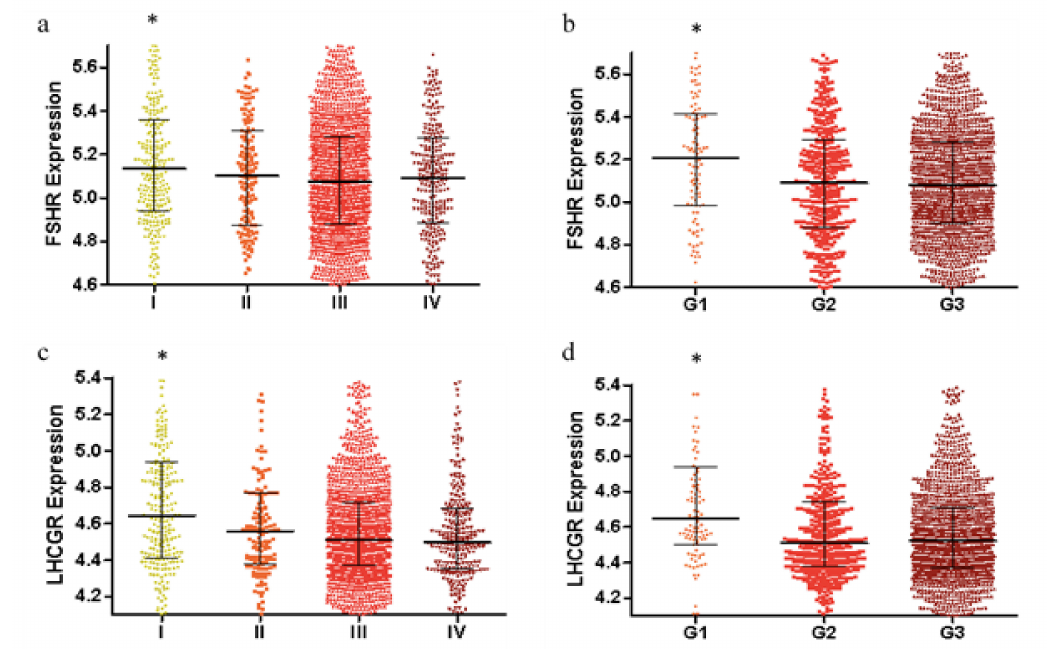
Figure 1. FSHR and LHCGR mRNA expression is increased in early stage and low-grade ovarian cancers: ( a ) FSHR expression in stage I, II, III and IV ovarian cancers; ( b ) FSHR expression in grade I, II and III ovarian tumors; ( c ) LHCGR expression in stage I, II, III and IV ovarian cancers. ( d ) LHCGR expression in grade I, II and III ovarian cancers. Total n = 3431 from CSIOVDB microarray gene expression database [20]. * p < 0.05 compared to the rest, Mann–Whitney U test from http://csibio.nus.edu.sg/CSIOVDB/CSIOVDB.html.